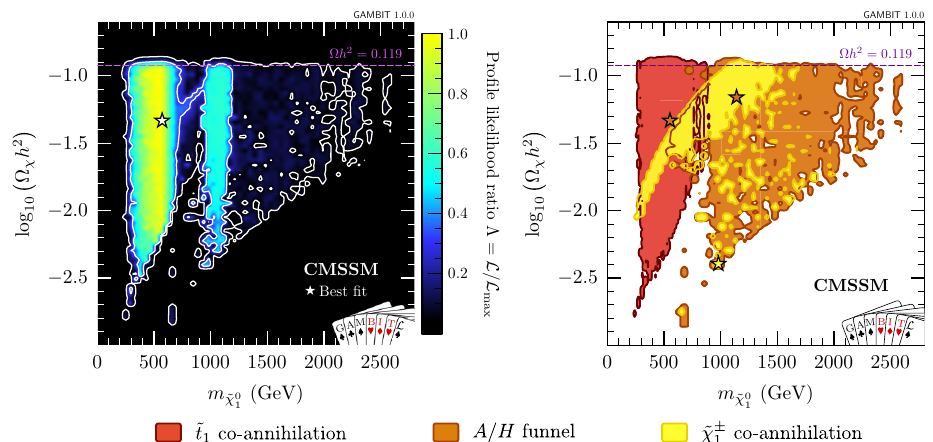
Fig. 1 Profile likelihoods and confidence regions for the CMSSM, in terms of the mass and thermal relic abundance ( (cid:12) χ h 2 ) of the lightest neutralino. Left: The profile likelihood ratio, plotted with 1 σ and 2 σ contour lines drawn in white, and the best fit point indicated by a star. Right: Mechanisms for ensuring that the relic density of DM does not exceedthemeasuredvalue,througheithercharginoco-annihilation,res-